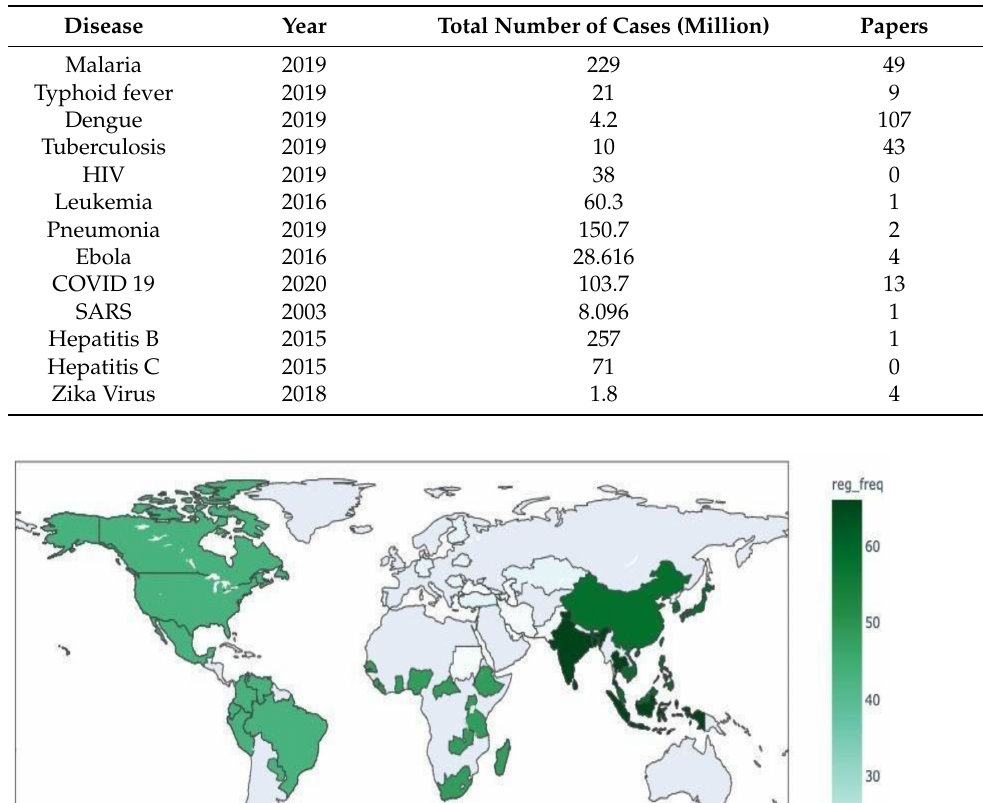
Table 7. Most Recent Outbreaks of Diseases and the number of papers that studied them.